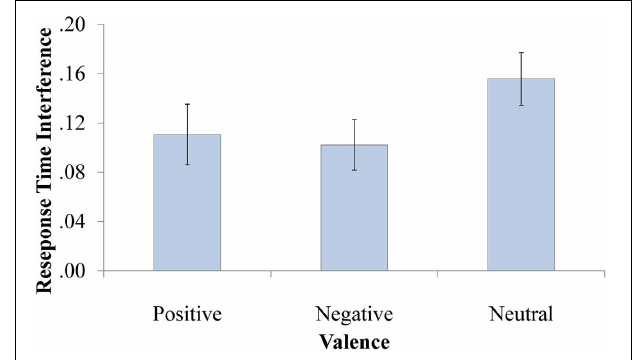
FIGURE 4 | Response time interference scores. Error bars represent standard